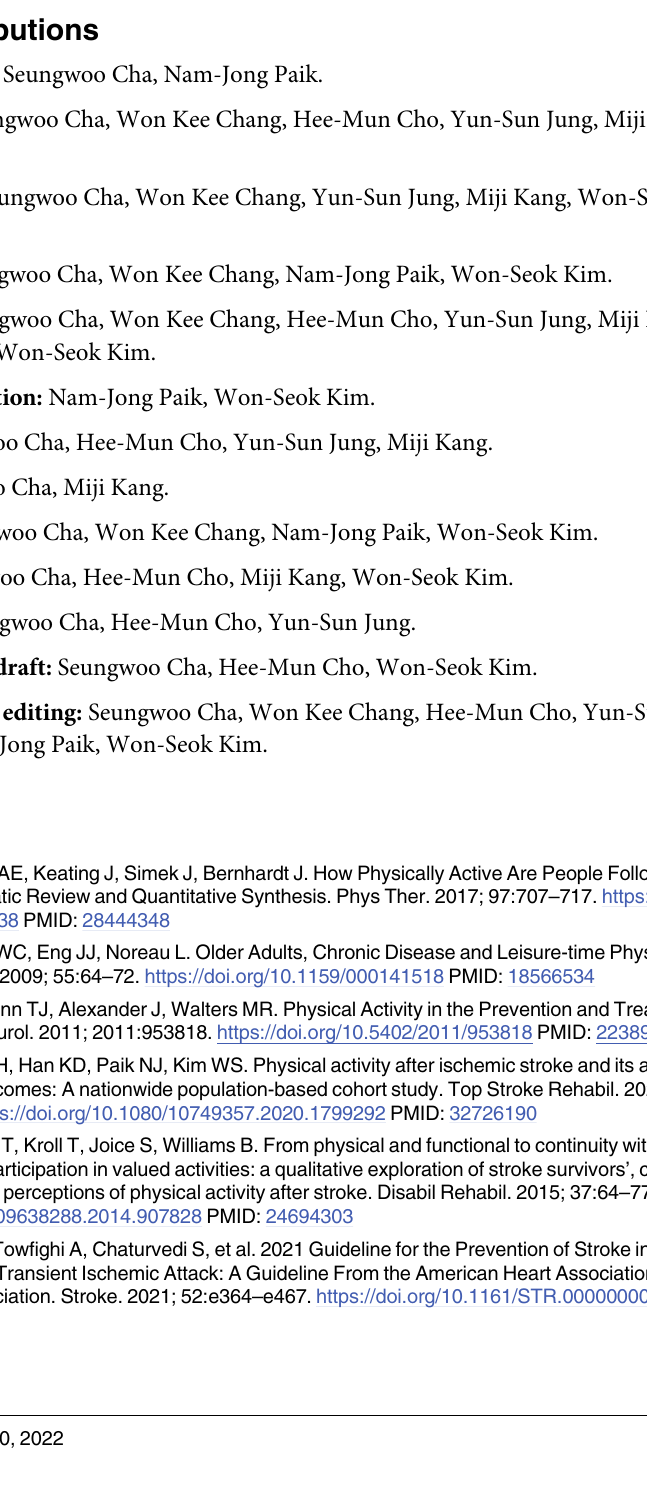
S4 Table. The change in mRS scores according to the group (intervention vs. control) or the change in PA. S5 Table. Comparison between the intervention group and excluded participants (read- mission, non-responder, and disagreement) admitted in